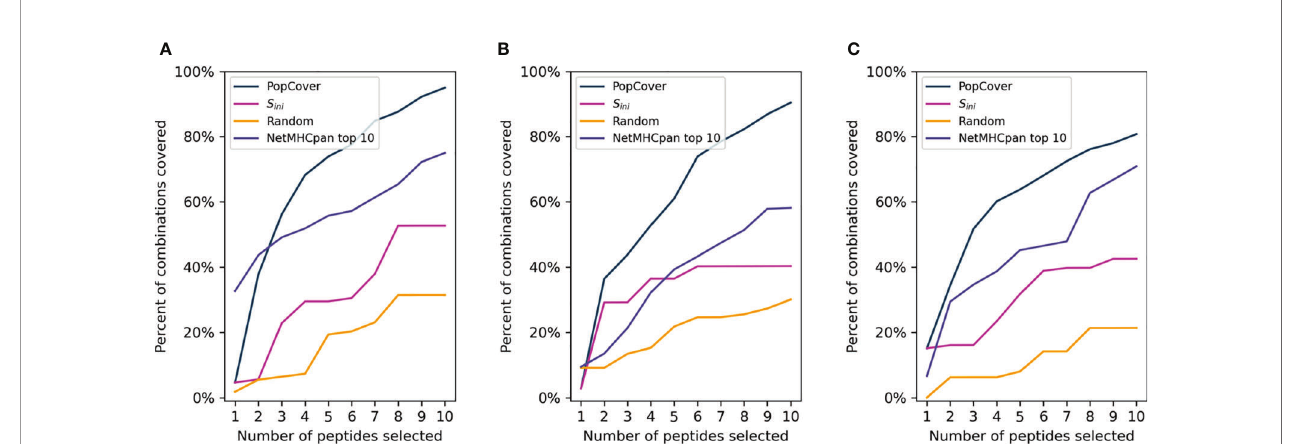
FIGURE 6 | Accumulative allele, genotype combination coverage of peptides selected by the PopCover, S ini , Random, and NetMHCpan top 10 methods for the three SARS-CoV-2 protein datasets ( A : S protein, B : N protein. C : ORF3a protein). For the PopCover, S ini and Random methods the percentages are calculated on the combined HLA-I and HLA-II allele sets, while the percentages for theNetMHCpan top 10 method are calculated on the HLA-I allele set